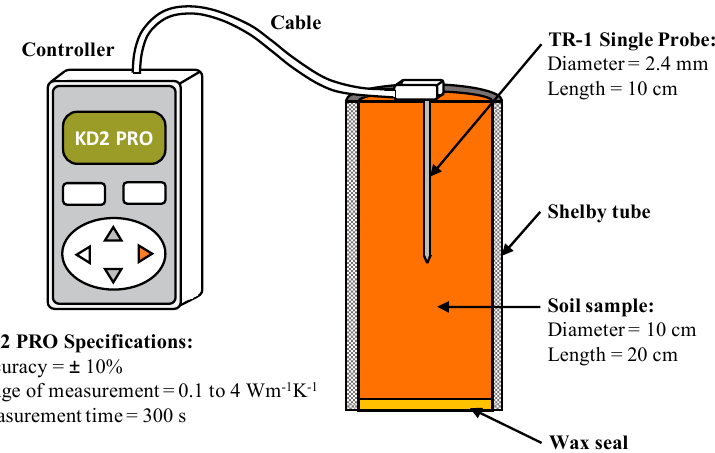
Figure 2. Measurement of thermal conductivity and experimental apparatus. Three measurements were taken for each sample with a time interval of 15 min. For each sample, an adequate input power was selected to prevent any potential errors from moisture migration and evaporation. The tests were performed in undisturbed cylindrical specimens of approximately 200 mm in length and 100 mm in diameter. To minimize the amount of soil disturbance (especially in the sandy soils) and to expedite the measuring process, it is suggested the tests are carried out before extruding the samples. Thus, in this study the tube seals were carefully removed, soil surfaces were cleaned, and then the TR-1 single probe was placed to carry out the test. In soils with a soft consistency, the sensor was inserted by simply pushing it into the specimen, whereas in coarse-grained materials a 2.5 cm hole was predrilled. The probe was coated within a thin layer of thermal grease to minimize contact resistance and was allowed to achieve thermal equilibrium in the soil mass (approximately 15 min) before the first